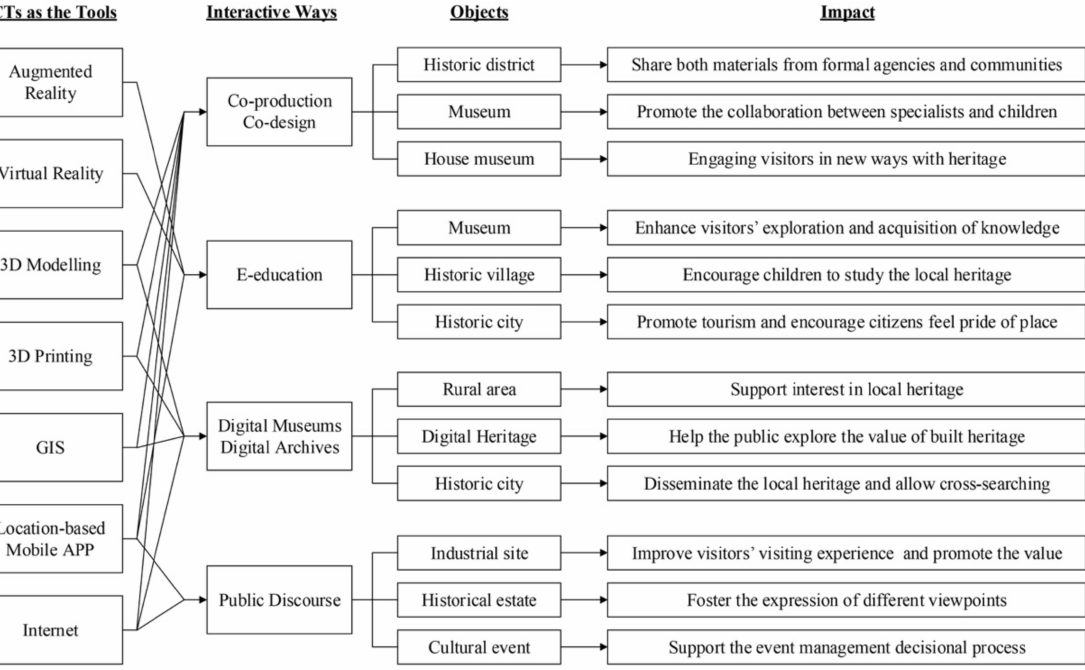
Figure 1. Current digital tools applied on involving public to cultural